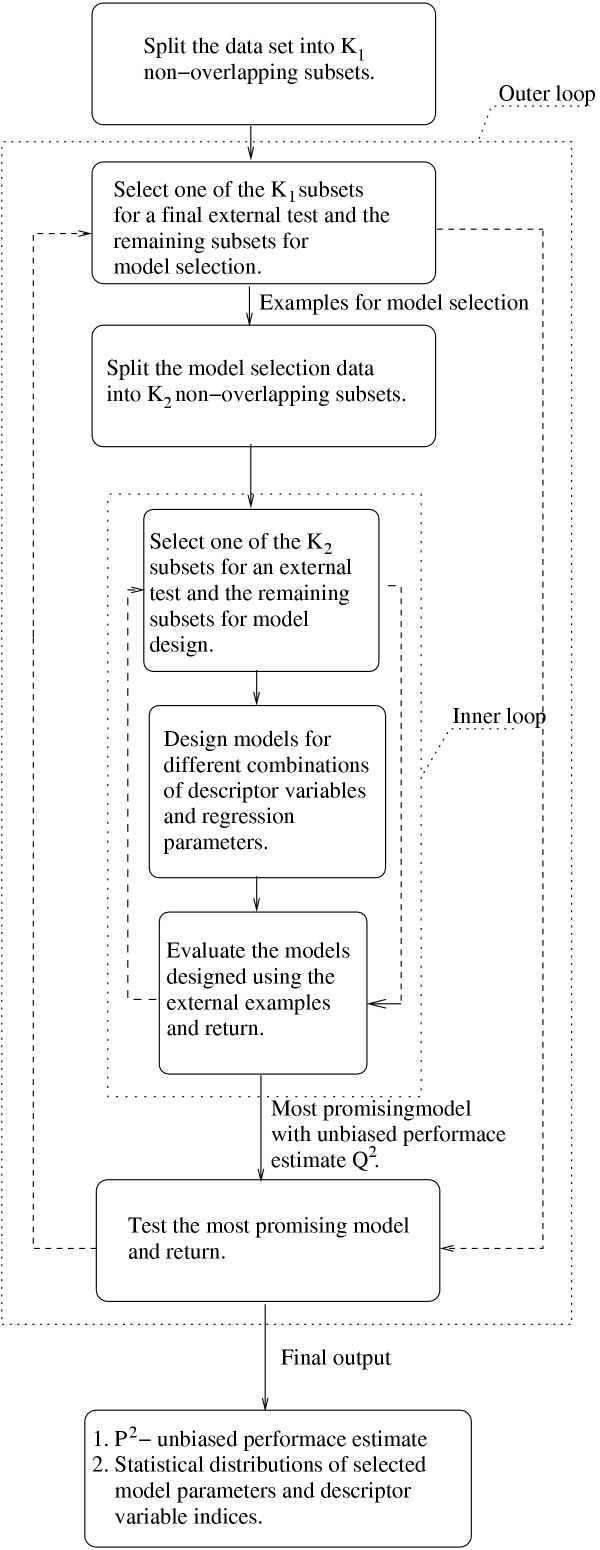
Overview of double loop. An overview of the double loop CV procedure used to obtain the desired unbiased performance estimate P2. In the embedded inner CV loop, the most promising model is selected which yields the largest unbiased performance estimate, Q2. In the outer CV loop, external test examples are kept outside the inner loop and are only used to test the most promising model found in the inner loop. Note that the estimate P2 reflects the average performance of the modelling procedure employed in the inner loop and that the estimate is based on many different models designed in the inner loop.